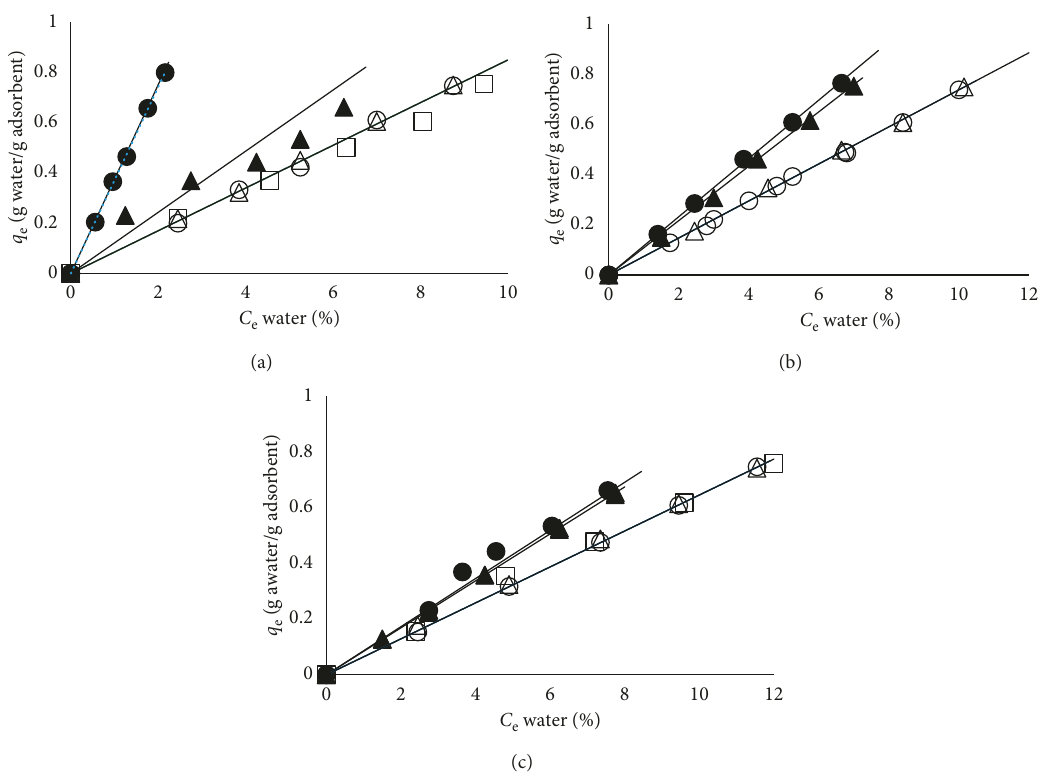
Figure 3: Adsorption isotherms of water at same temperature in various adsorbents. (a) 22 ° C; (b) 30 ° C; (c) 40 ° C. , q q PVA/Zeo/AC 1:1:0.75; , q eks